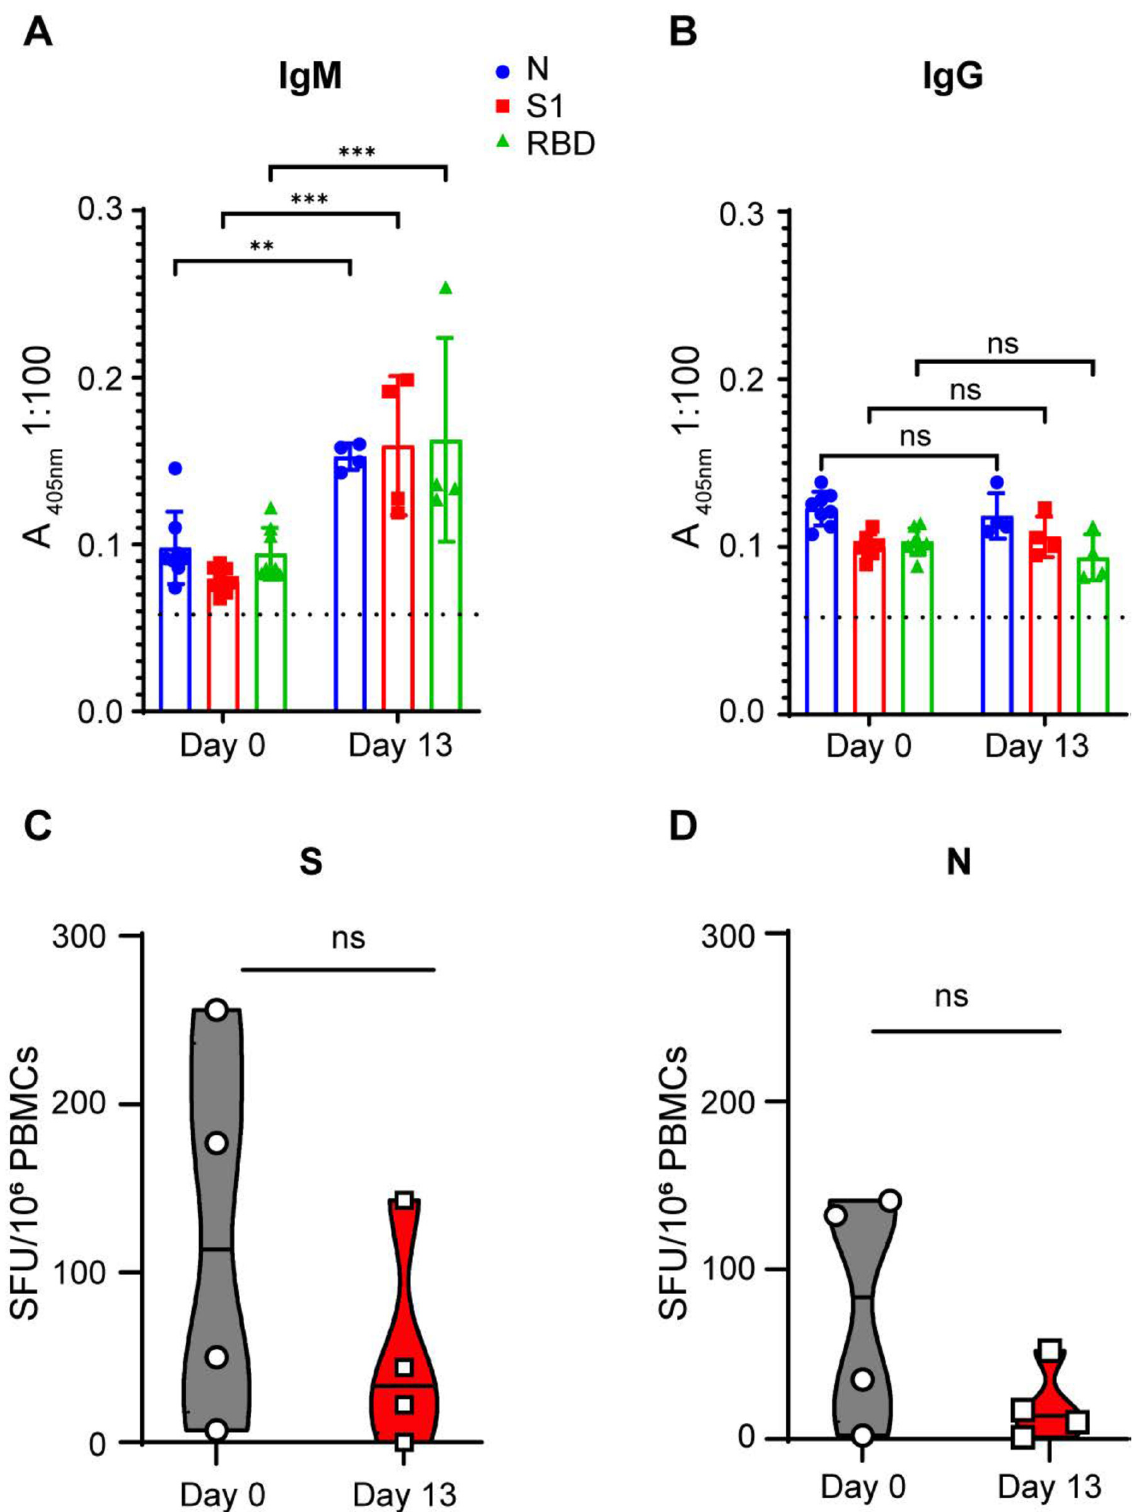
Figure 3. Immune responses to SARS-CoV-2 infection in 3-week-old pigs. Blood samples were collected on 0 DPI and 13 DPI to determine adaptive immune responses. ( A , B ) Humoral